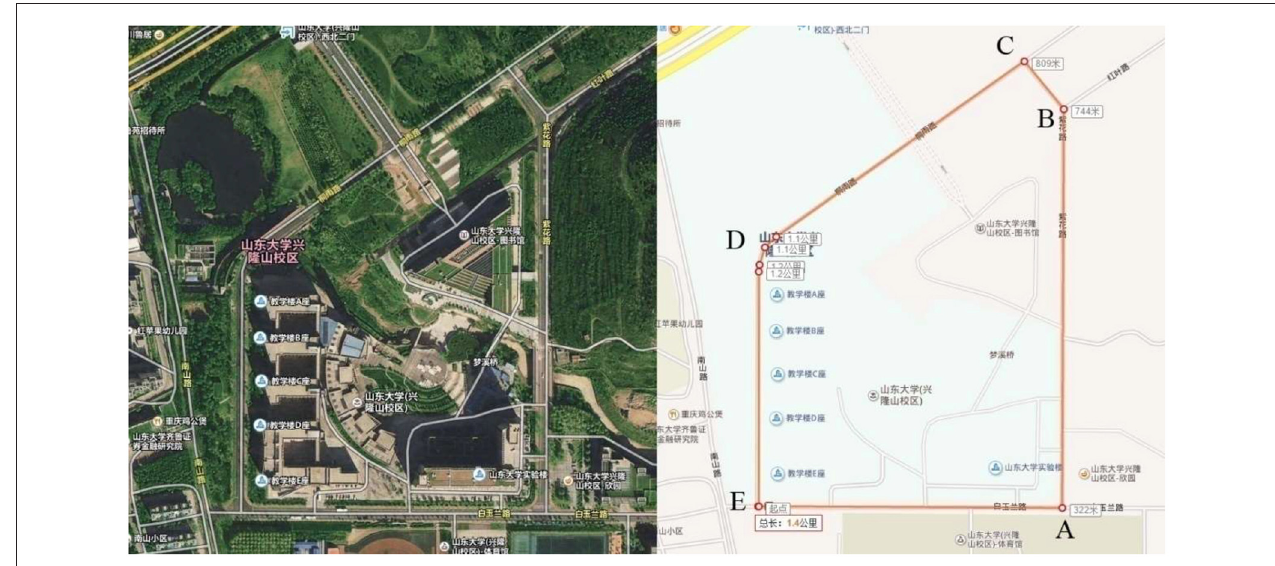
FIGURE 1 | Experiment location. The driving route is cycling as A-B-C-D-E-A.